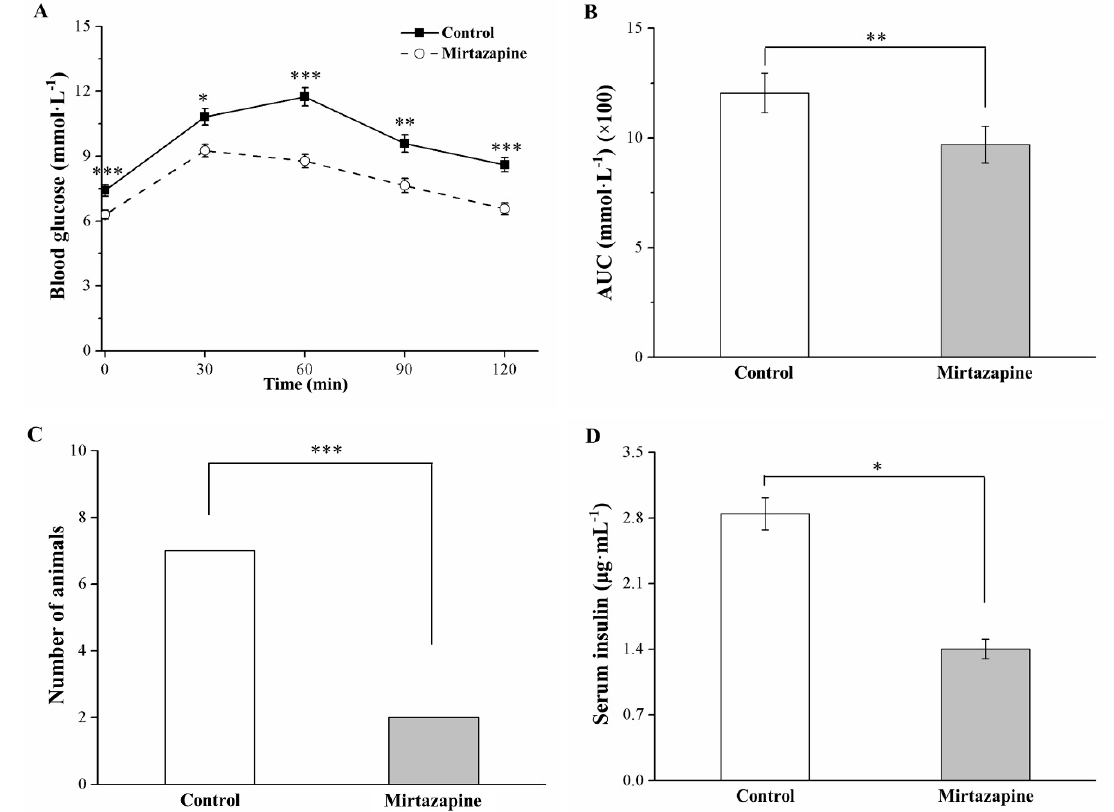
Figure 5. Changes in ( A ) intraperitoneal glucose tolerance test (IPGTT) (1 g of glucose / kg body weight), ( B ) area under the curve (AUC) over 120 min after glucose injection, ( C ) glucose intolerance criterion (Fisher’s exact test), and ( D ) serum insulin levels in the control and 10 mg / kg / day mirtazapine-treated mice over the 28 treatment days. We present all data in this figure mean ± SEMs (n = 10) for both groups. * p < 0.05, ** p < 0.01, *** p <